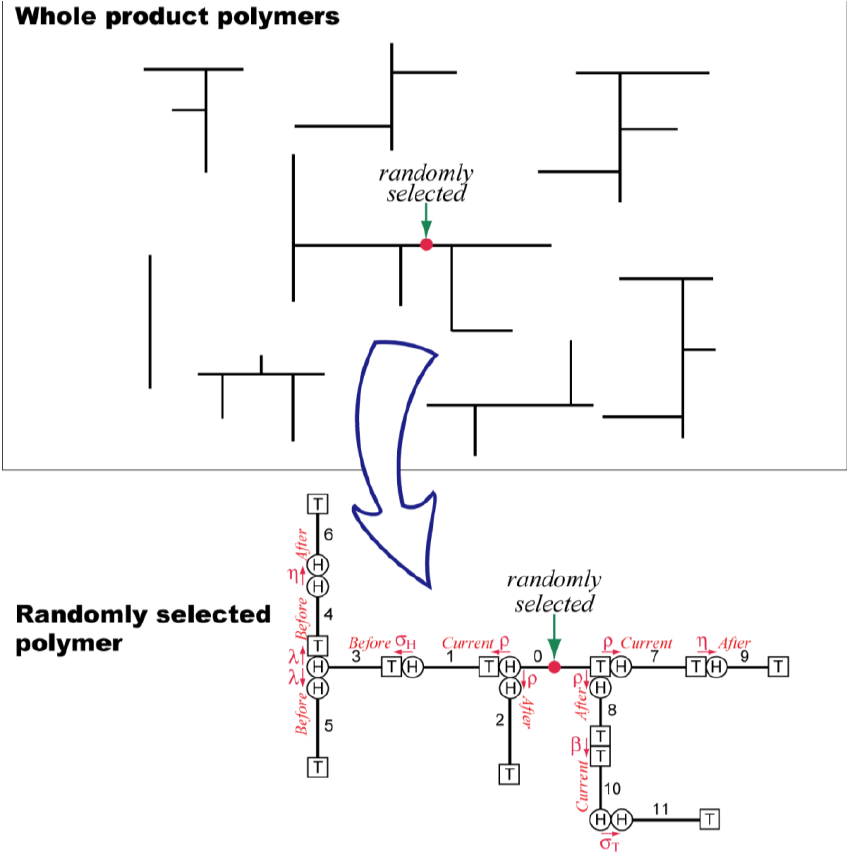
Figure 6. Schematic representation of the concept of random sampling